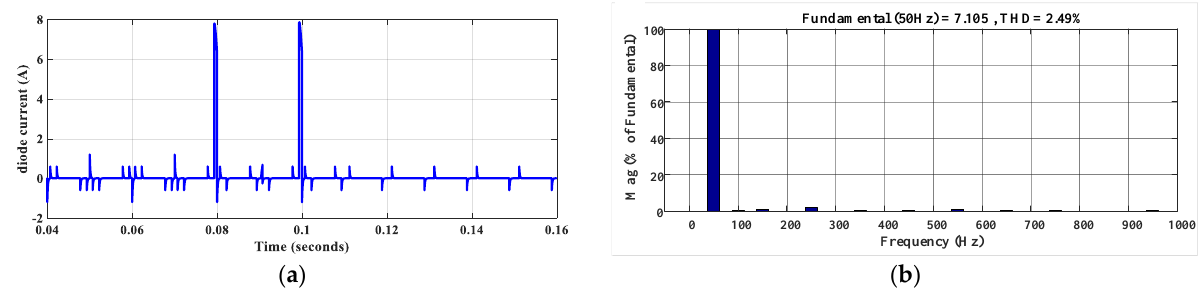
Figure 9. Simulation results for S 6 fault for ( a ) diode current and ( b ) current harmonic profile.